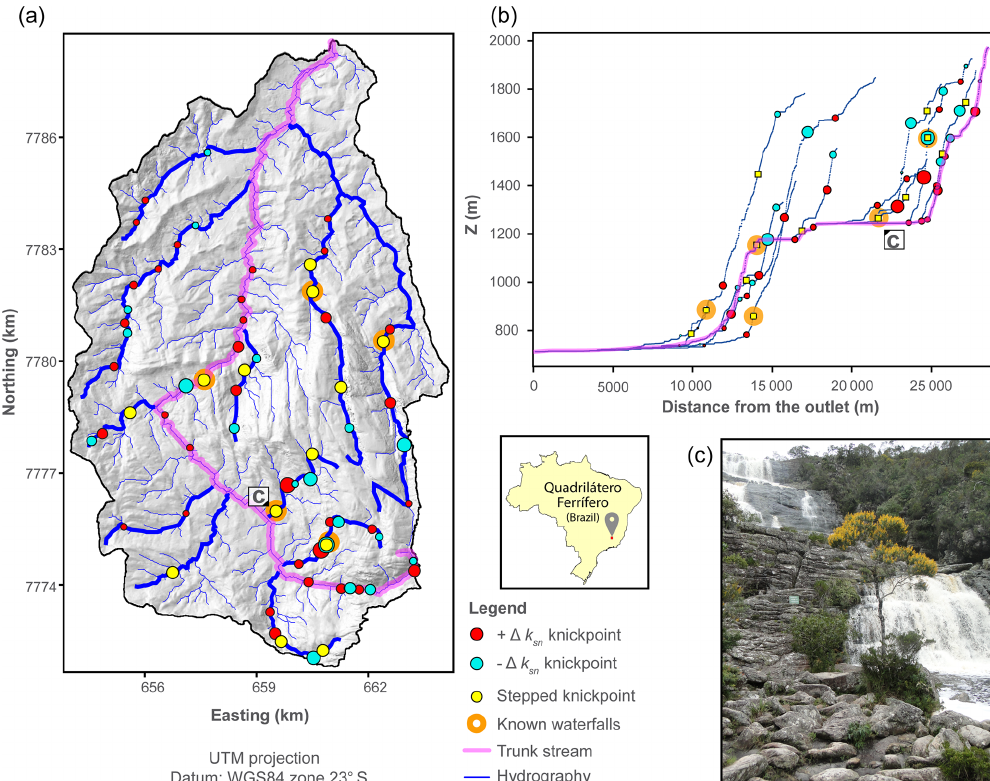
Figure 8. Knickpoint extraction on the Ribeirão Caraça basin (Caraça Range, QF, Brazil). (a) Map of knickpoints extracted with the algo- rithm after thinning the dataset as described in Sect. 4.2. Most of the calibration knickpoints are expressed by a succession of knickpoints detailing along-channel increases and/or decreases in k sn . Streams depicted in panel (b) are shown as thick blue lines. (b) Longitudinal profile of the trunk stream (the Ribeirão Caraça river) highlighting the performance of the algorithm in picking along-channel breaks in steepness. (c) Example of a known waterfall (i.e. waterfall with a name) in the field: the Cascatinha waterfall. This waterfall features an elevation break of 40m. Other known waterfalls include the Cascatona, Bocaina, Brumadinho and Quebra-ossos waterfalls.